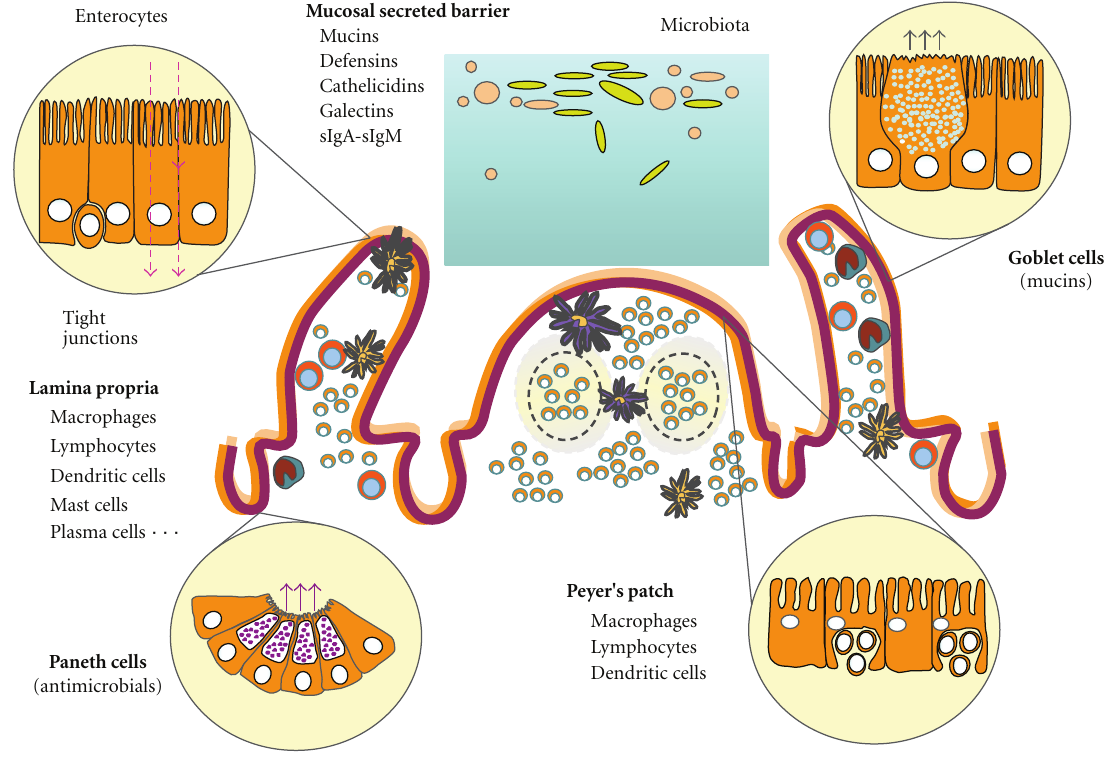
Figure 1: Components of the gut